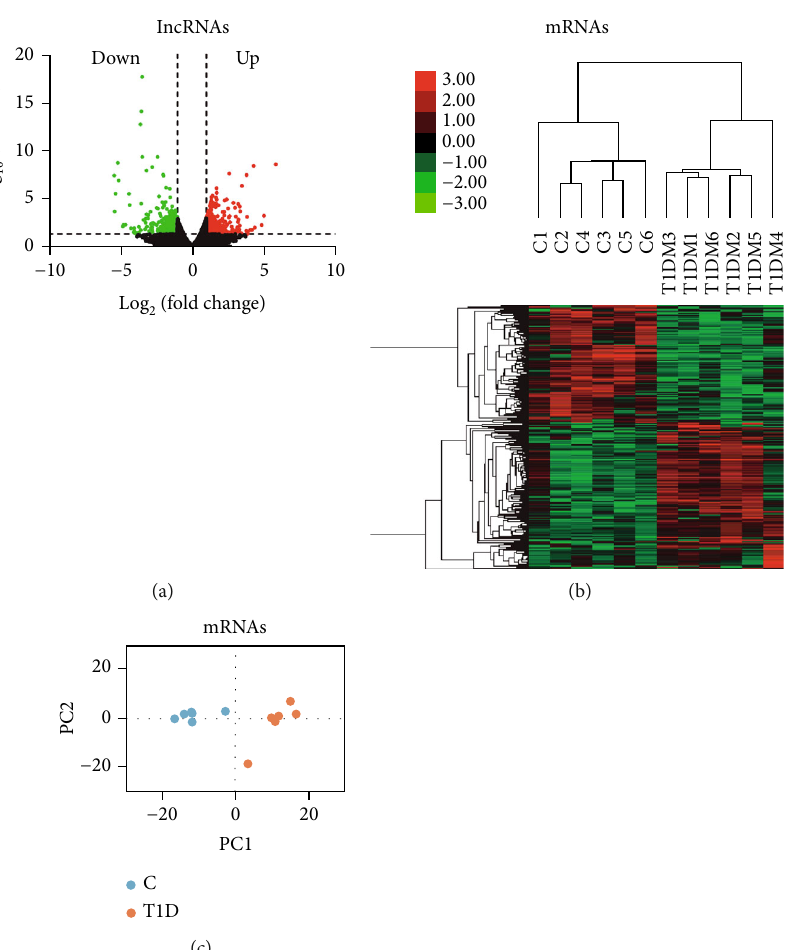
Figure 3: Transcriptomic landscape of T1D-mRNAs. (a) T1D di ff erentially expressed mRNAs (T1D-mRNAs) were identi fi ed from the volcano plot in T1D patients relative to normal controls. The vertical black lines correspond to twofold up- and downregulation, respectively, and the horizontal black line represents a p value of 0.05. The red and green points in the plots represent di ff erentially expressed transcripts with statistical signi fi cance for upregulation (172 mRNAs) and downregulation (139 mRNAs), respectively. (b) Di ff erential mRNA expression pro fi les were hierarchically cluster analyzed and shown as heat maps, wherein upregulated genes are depicted in red and downregulated genes are depicted in green. (c) Principal component analysis also showed that mRNAs are distinguishable between T1D patients and